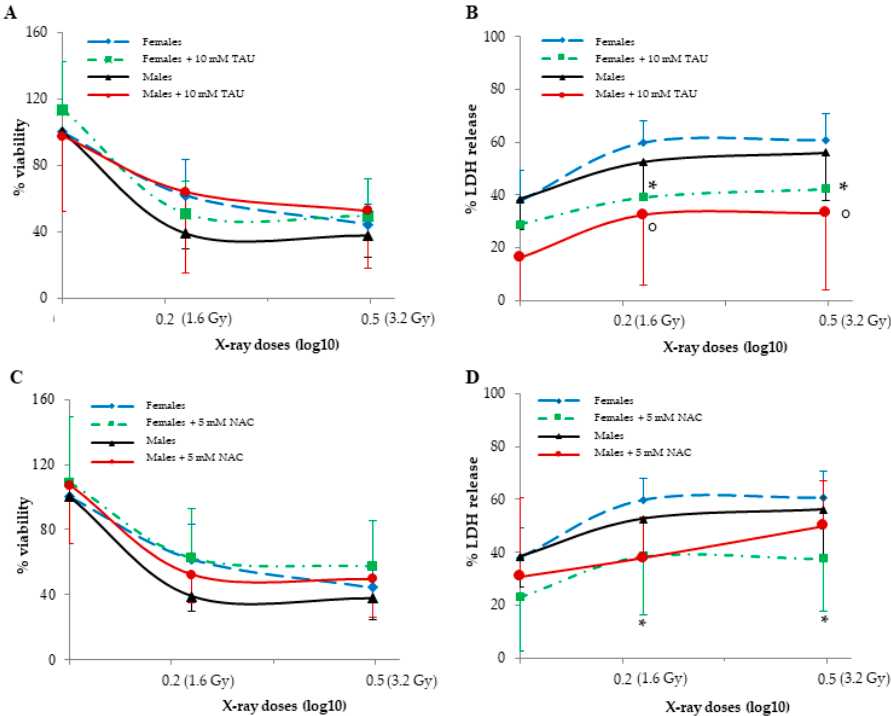
Figure 1. The effects of TAU and NAC pre ‐ treatments on viability ( A , C ) and LDH release ( B , D ) in non ‐ irradiated and irradiated female and male HUVECs. Data are reported as the means ± SD of 6–7 samples for each sex and dose. ° represents a p < 0.05 versus non ‐ irradiated cells in MHUVECs, while * represents a p < 0.05 versus non ‐ irradiated cells in FHUVECs.